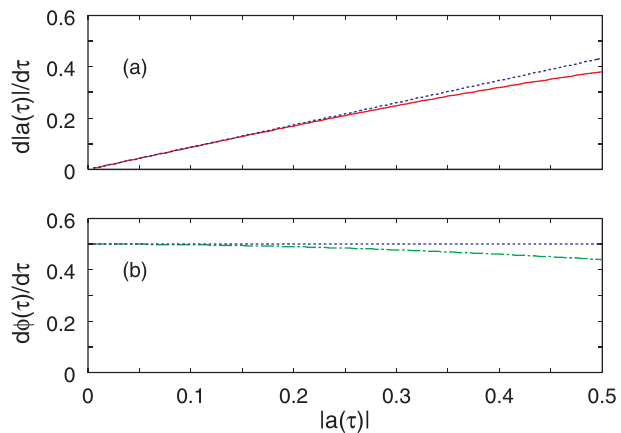
FIG. 4. (Color) The amplitude gain at time (cid:6) , d j a (cid:2) (cid:6) (cid:4)j =d(cid:6) , calcu- lated from Eq. (20) is given by the solid curve in (a) as a function of j a (cid:2) (cid:6) (cid:4)j . The phase shift d(cid:9) (cid:2) (cid:6) (cid:4) =d(cid:6) calculated from Eq. (21) is represented by the dash-dotted line in (b). The dotted lines in (a) and (b) stand for Eq.